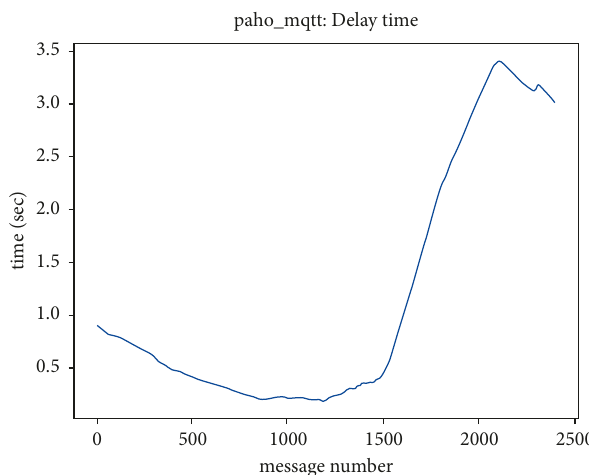
Figure 13: PahoMQTT’s latency with a frequency of 1000 messages per second and different message sizes.